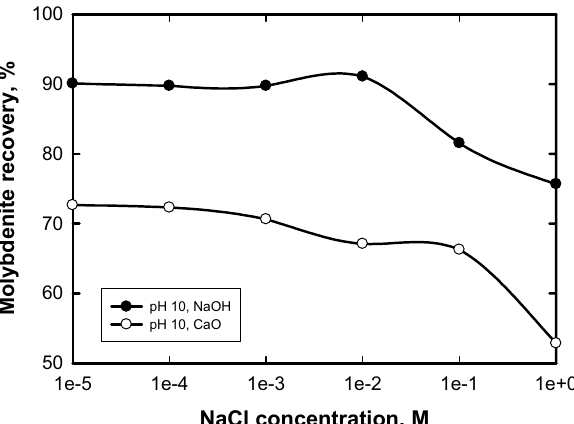
Fig. 13 Effect of NaCl concentration on the flotation of molybdenite at a pH of 10 adjusted either by NaOH or CaO 30) .